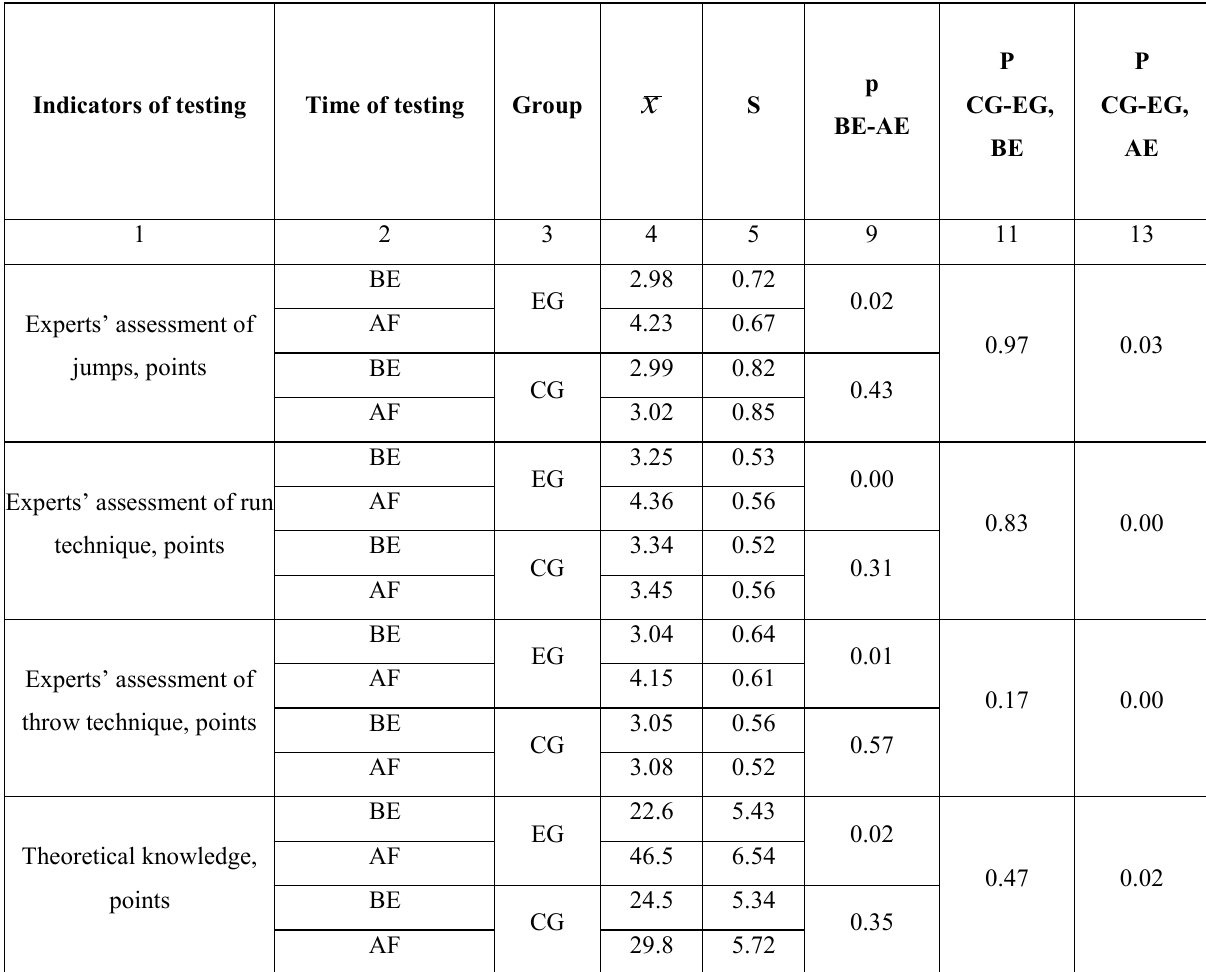
Indicators of motor abilities and skills of control (n=34) and experimental groups’ pupils before and after experiment (boys)